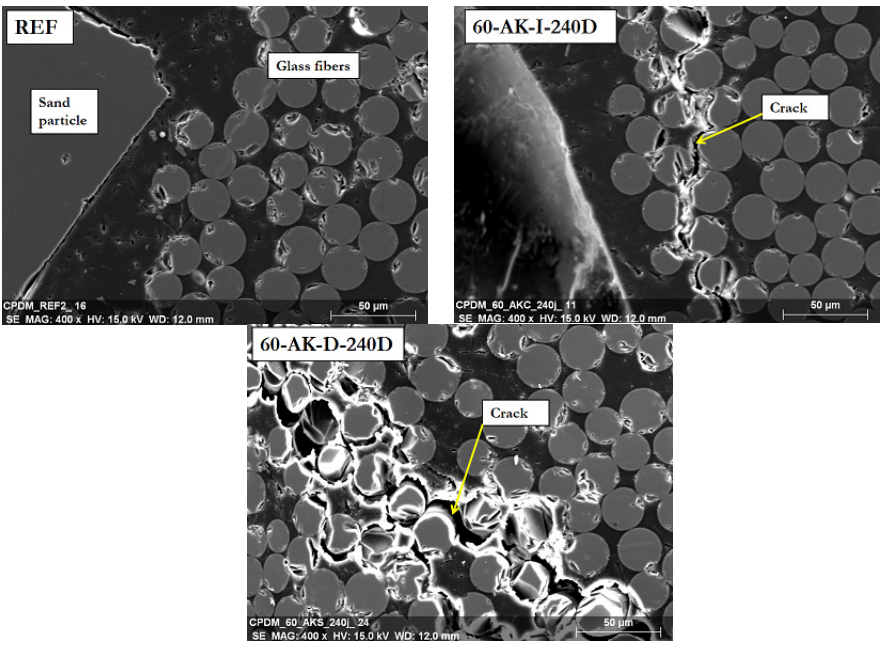
Figure 9. SEM images of the cross section of reference and aged GFRP rebars, at locations close to the external sand coating layer.